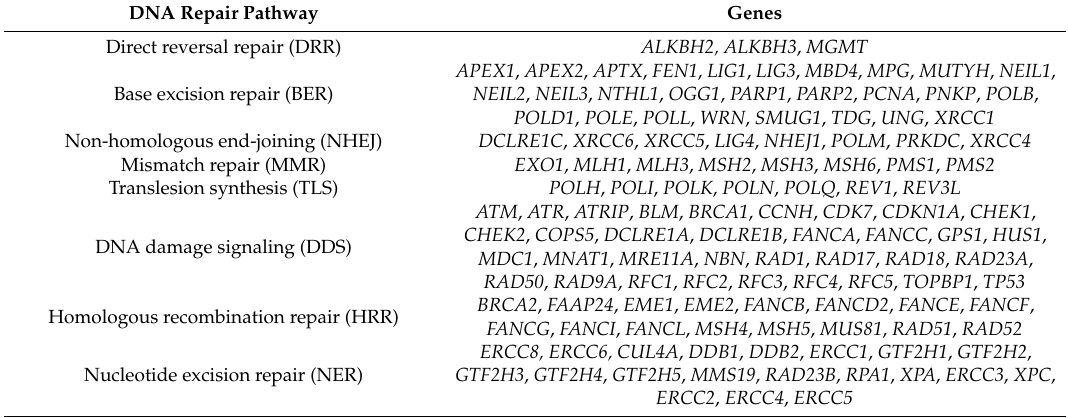
Table 1. DNA repair pathways and 123 genes employed in this study for overall survival (OS) prediction. DNA Repair